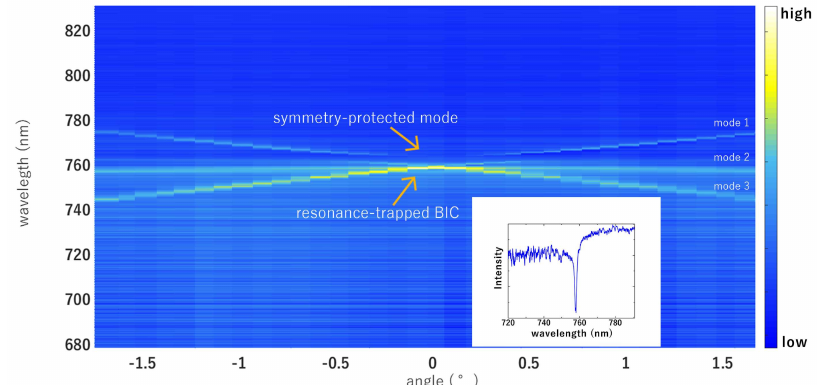
Figure 2. Dispersion band diagram along Γ X direction close to the normal incidence. The superior band is characterized by a vanishing linewidth towards θ = 0 ◦ . The first singly-degenerate mode 1 is a symmetry-protected bound state in the continuum (BIC). The inferior degenerate band (modes 2 and 3) instead shows avoided crossing resonances at Γ splitting, and is associated to a resonance-trapped BIC. The inset shows the transmitted spectrum at θ = 0 ◦ .